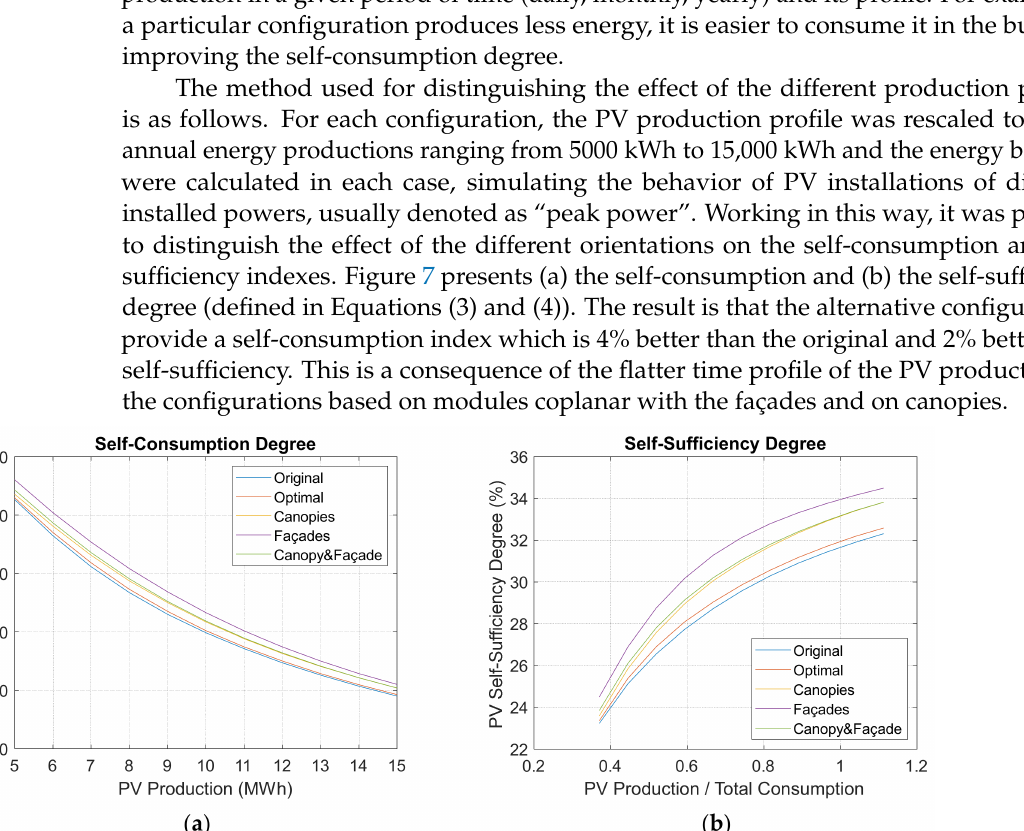
Figure 7. Self-consumption ( a ) and Self-sufficiency ( b ) degree vs. PV production relative to the consumption for the simulated